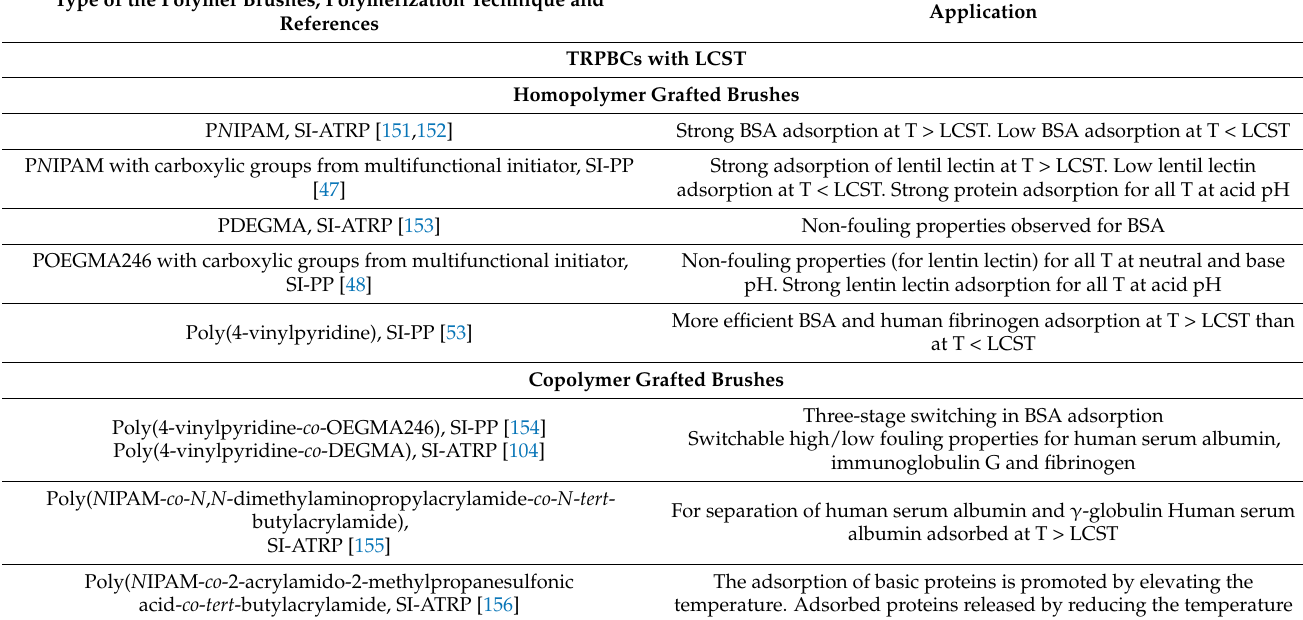
Table 5. Summarized information about application of the TRPBCs for temperature-controlled protein